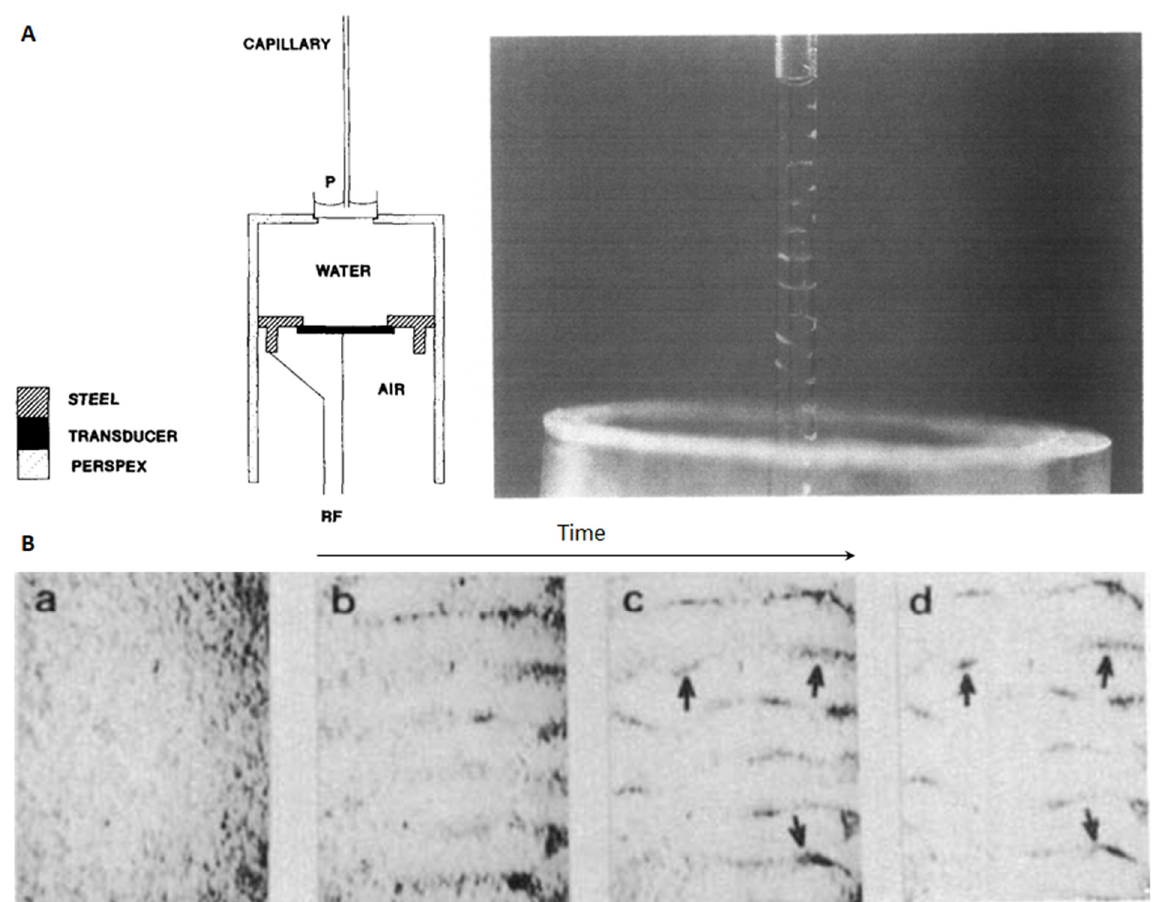
Figure 11. Acoustic microparticle patterning in the flow direction of circular cross-section glass capillaries. ( A ) Acoustic agglutination of Legionella pneumophila in a circular glass capillary ( 𝑑 = 1 mm) containing antiserum. Presented is a photograph of the agglutinates 20 s after exposure to ultrasound. Reprinted with permission from [68] . ( B ) In a device similar to A , erythrocytes were well patterned by ultrasound along the fluid channel of the glass capillary ( 𝑑 = 13 mm). Reprinted with permission from [69] .